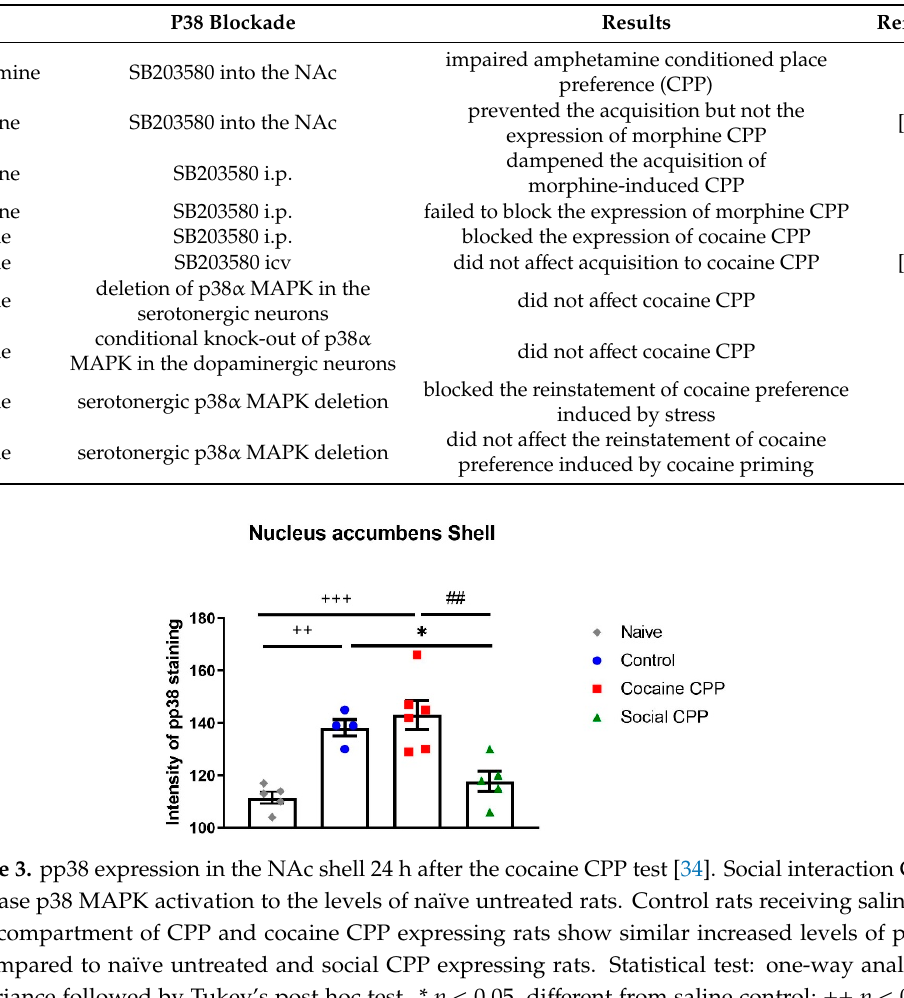
Table 1. Summary of the findings describing the role of p38 MAPK in drug reward.